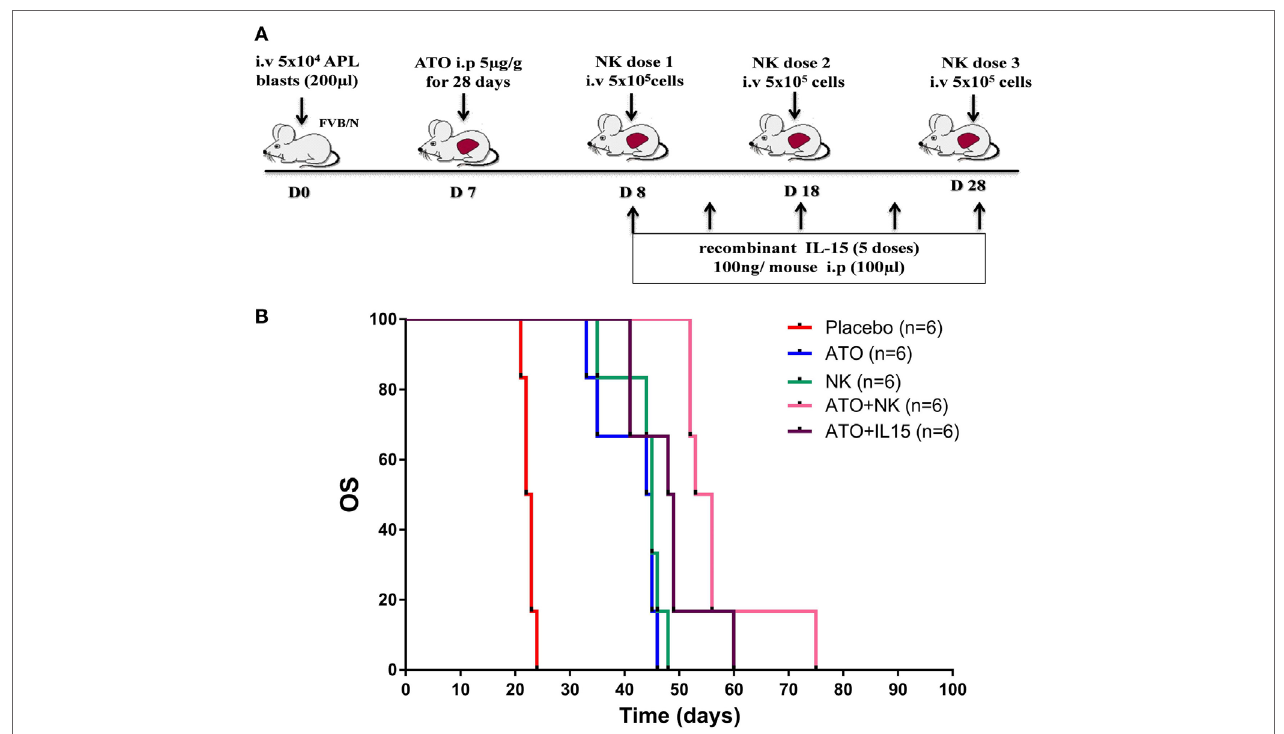
FigUre 5 | NK cell therapy improved the overall survival in acute promyelocytic leukemia (APL) mice. (a) Schematic representation of NK cell therapy in APL mouse model. The time points and doses of administration of arsenic trioxide (ATO), NK cells, and IL-15 were mentioned. Mouse APL cells (5 × 10 4 cells/mouse) were injected intravenously via tail vein into wild-type FVB/N (Day 0). ATO (5 µg/g intra-peritoneal) was given from day 7 for 28 days. NK cells were sorted from the spleen of wild-type FVB/N and given intravenously (5 × 10 5 NK cells/mouse, 3 doses) from day 8 with 10 day intervals. Recombinant mouse IL-15 (100